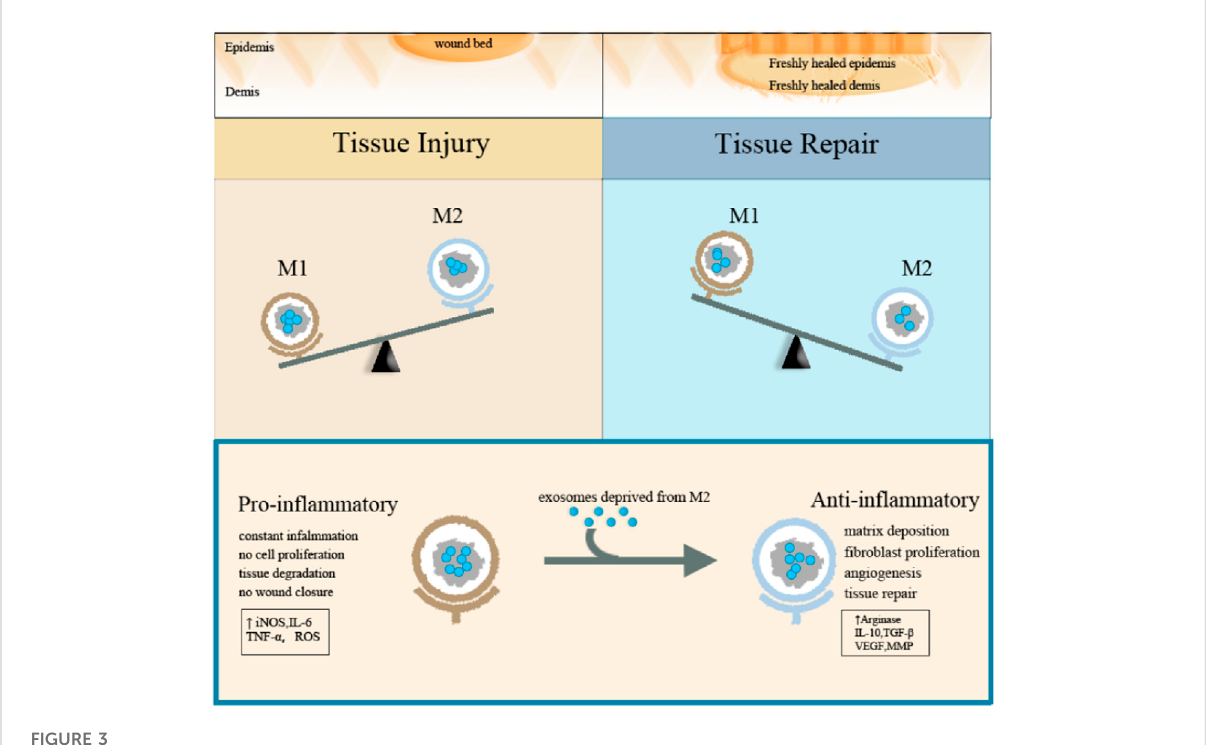
FIGURE 3 Schematic diagram of the function of macrophage